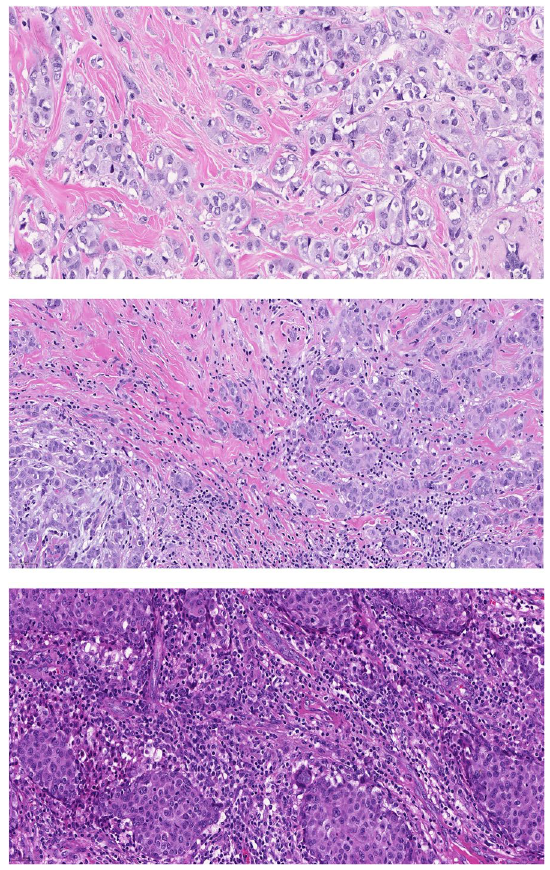
Fig. 2 H&E stained sections of PTs ( a ) PT with Tils 1% ( b ) PT with Tils 10% ( c ) PT with Tils